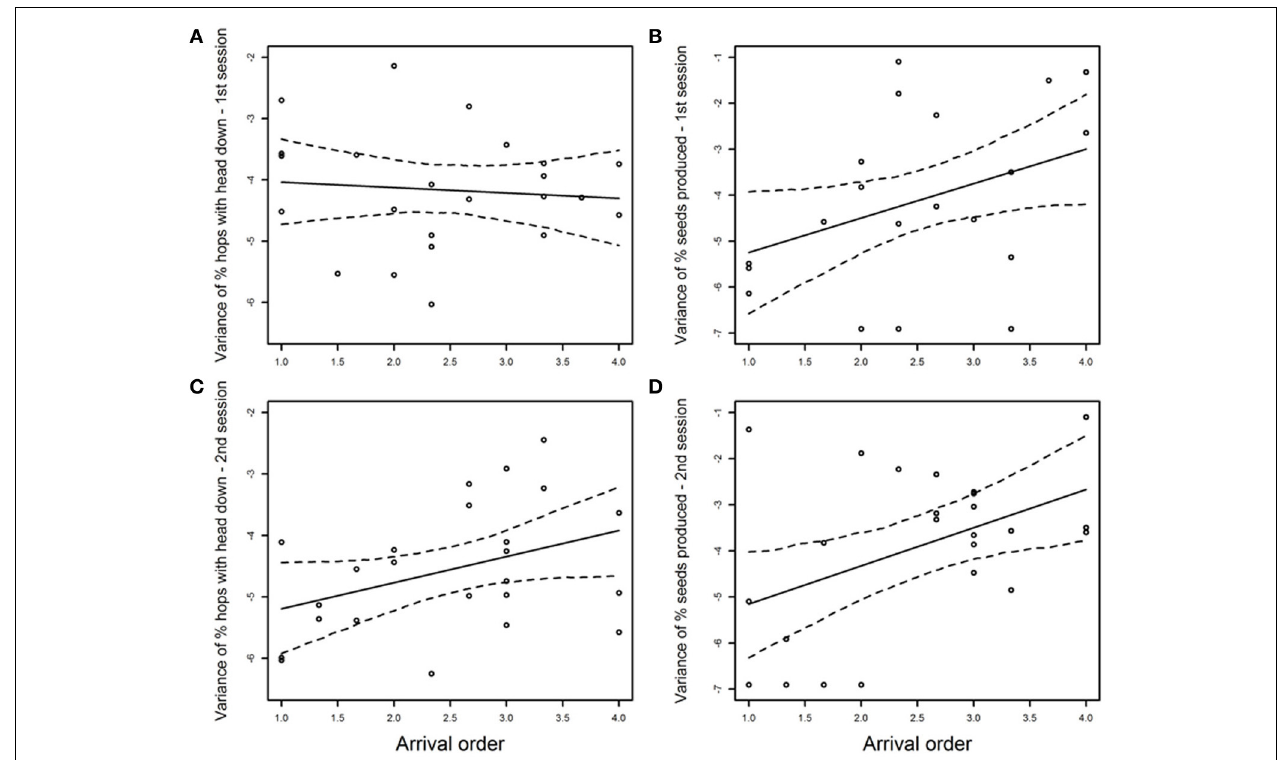
FIGURE 2 | Influence of arrival order on the variance in proportion of hops with the head down (log-transformed) in first (A) and second session (C), and on the variance in proportion of seeds produced